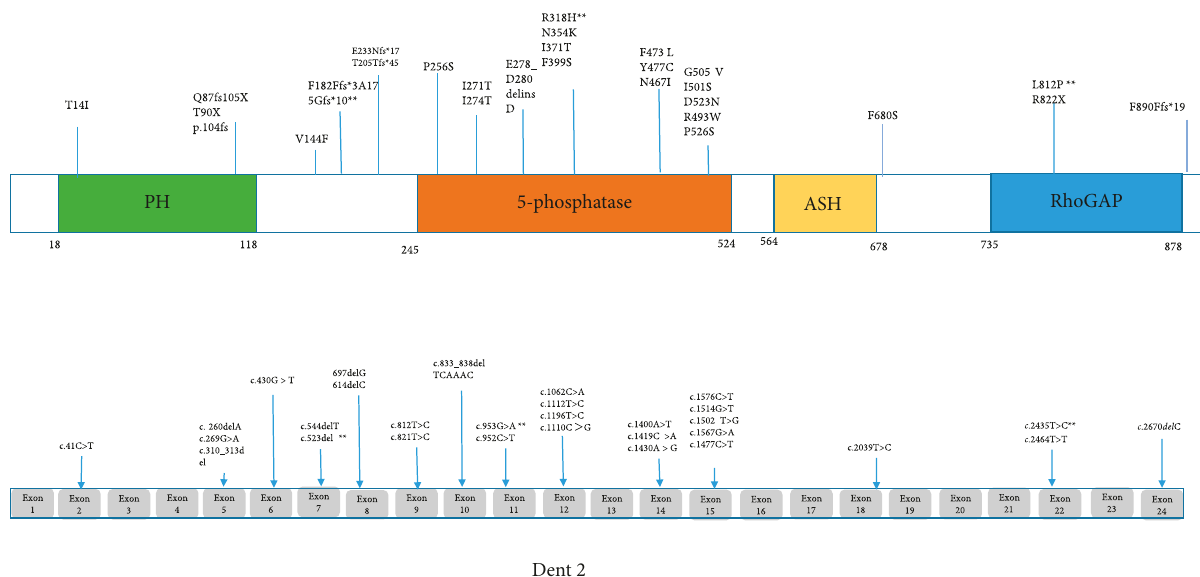
Figure 2: Exon structure of the OCRL gene with geometric shapes indicating relative positions of different types of mutations in Dent-2 disease. Differences of mutation type and mutation location between Lowe syndrome and Dent-2 disease.